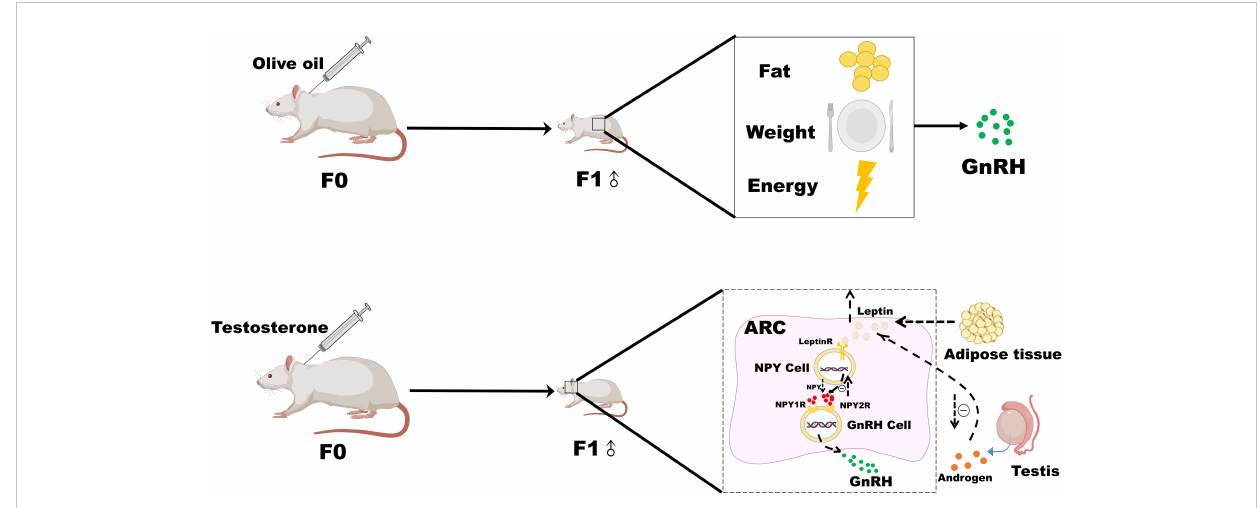
FIGURE 3 Possible mechanism of leptin-NPY on the onset of puberty in male offspring rats after androgen intervention during